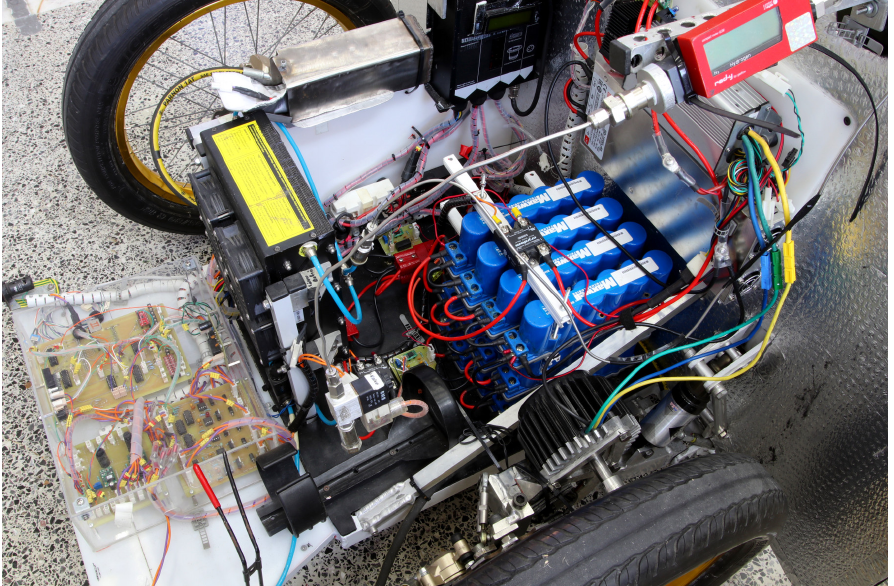
Figure 3. The powertrain compartment of the Spyros Louis